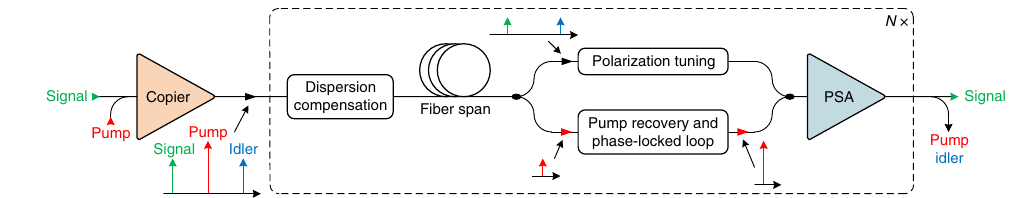
Fig. 1 Long-haul PSA-ampli fi ed link. Conceptual schematic of a long-haul PSA-ampli fi ed link implemented using the copier-PSA scheme